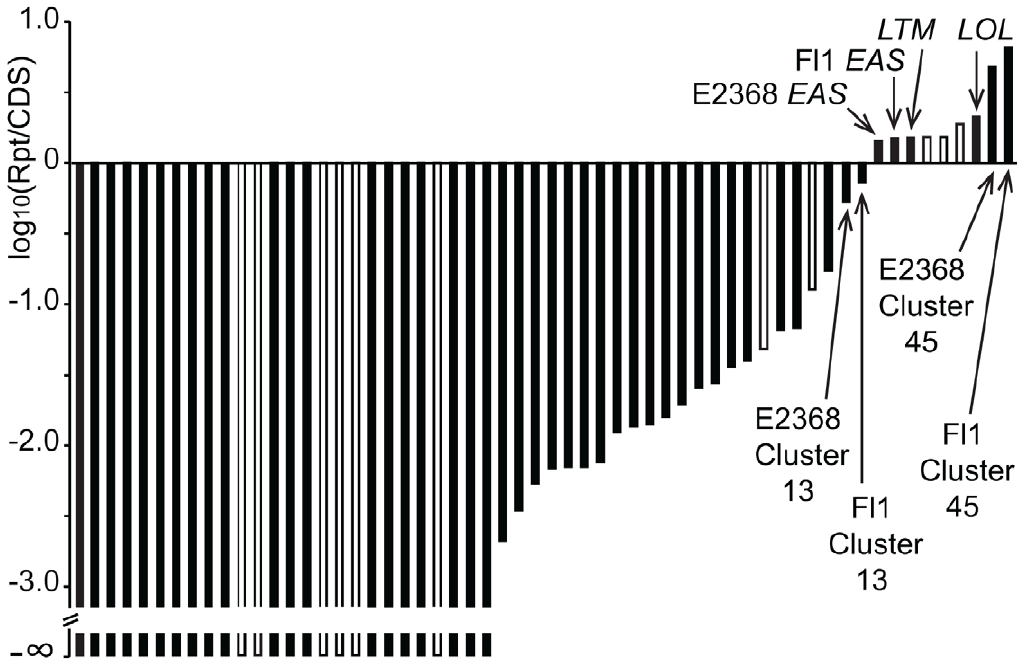
Figure 12. Relative repeat contents in specialized metabolite clusters of Epichloe¨festucae . Log-ratios of repeat sequences (Rpt) to coding sequences (CDS) are shown in order of increasing proportions of repeats. Open boxes represent clusters that are apparently nonfunctional due to inactivation of signature genes.